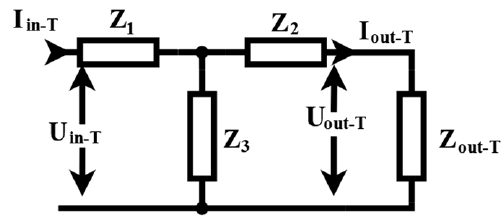
Figure 2. T-type circuit model.